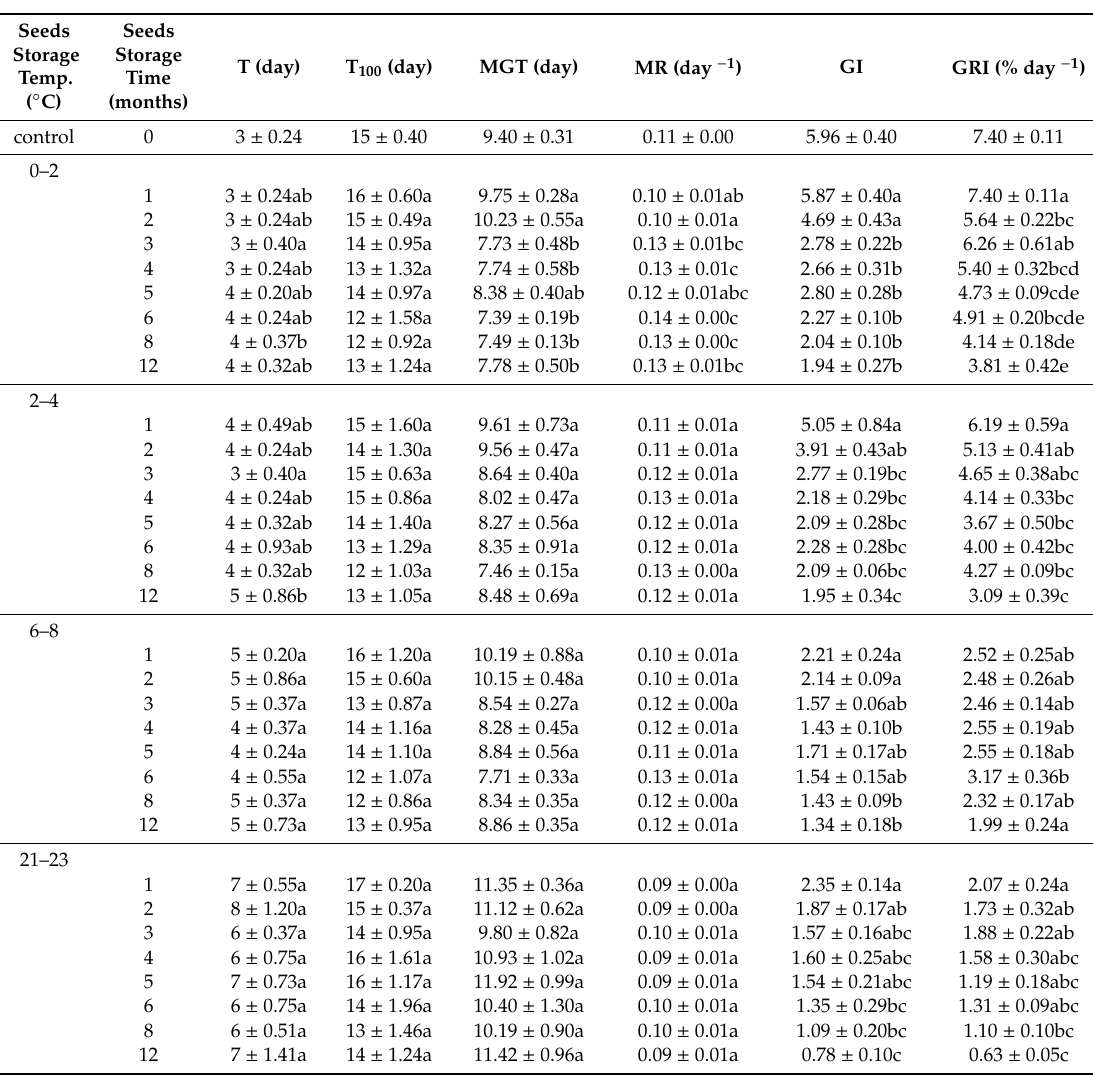
Table 4. The germination characteristics of C. calyculata seeds stored in various temperatures for various periods of time. The results are the means with standard error ( ± SE). The numbers followed by the same letter in each column at a given seeds storage temperature are not significantly di ff erent ( p < 0.05). Seeds Storage Temp. ( ◦